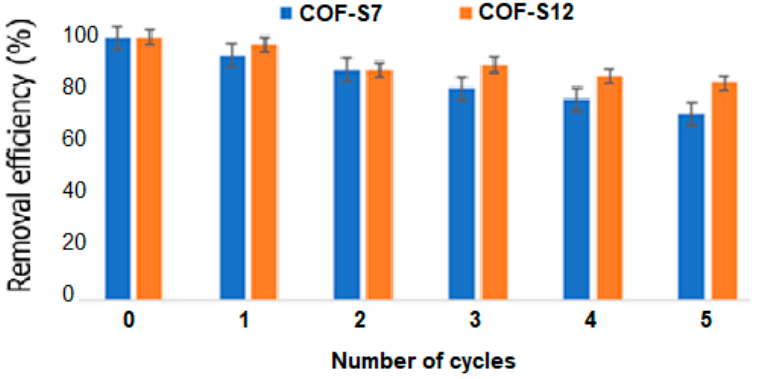
Figure 13. Adsorbed amount of naproxen over adsorbents (COF-S7 and COF-S12).